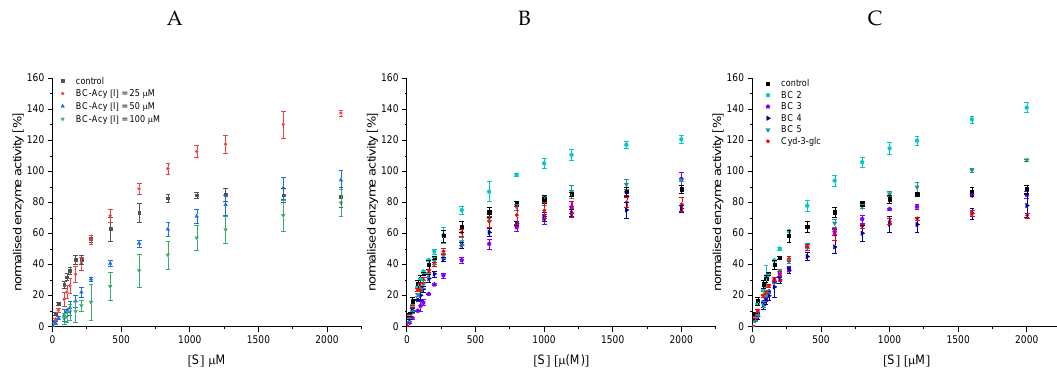
Figure 5. Decrease in conversion rate of GalG 2 CNP by addition of 25 − 100 µM black carrot anthocyanin extract (BC-ACY), the complex anthocyanin extract ( A ), and by 12.5 ( B ) and 25 µM ( C ) isolated anthocyanin-3-glycosides. Cyd-3-glc is included in the plot for comparison purpose. Abbr.: [S], substrate concentration; BC 2, Cyd-3-gal-xyl; BC 3, Cyd-3-gal-xyl-glc(sin); BC 4, Cyd-3-gal-xyl-glc(fer); BC 5, Cyd-3-gal-xyl-glc(cum). Inhibition constants for BC 4 were obtained by the global fit for the mixed and competitive inhibition according to Equation (4a,b), respectively (Figure 6, Figure S3). The high standard deviation for α (calculated by origin, K iu = K ic ∙α) and a K iu value markedly exceeding K ic also support a predominantly competitive inhibition. The K ic value of 20 µM should only be a rough estimation due to the general error (increase in conversion rate in the presence of BC 2, BC 3, and BC 5) in the UV/Vis detection. However, it indicates an improved inhibition compared to the non-acylated anthocyanin-3-glucosides (Table 1). 3.4. Determination of α -Amylase Inhibition by Anthocyanin-3-Glucosides Using Isothermal Titration Calorimetry Due to the simulated increase in enzyme activity by addition of black carrot anthocyanins determined by UV/Vis spectroscopy, the inhibitory effect was additionally investigated by ITC to prove the assumed stronger inhibition of α -amylase by acylated structures than by non-acylated anthocyanins. The thermogram, as well as the extracted Michaelis Menten plot, shows a significantly stronger inhibition of BC 4 compared to the non-acylated BC 2 and Cyd-3-glc (Figure 7). For the complex anthocyanin extract, a significant improved inhibition is obvious, to a smaller extent than for BC 4, however. This finding is in contrast to the UV/Vis detection (Figure 5), which simulates an